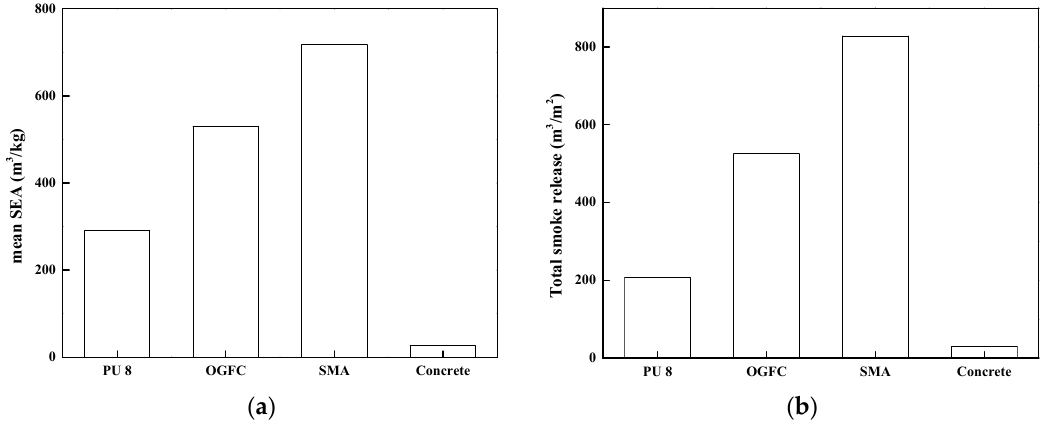
Figure 13. Comparison of the results among PU, OGFC and SMA. ( a ) mean for the specific extinction area (SEA); ( b ) total smoke release (TSR).